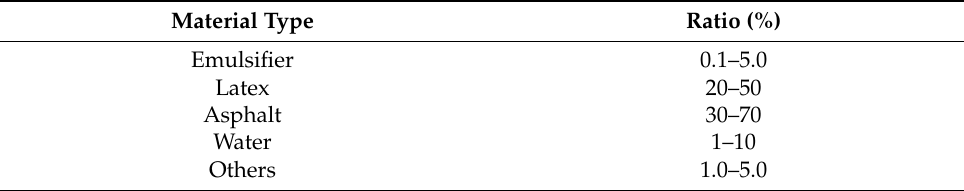
Table 1. Mixing ratio of water-soluble rubber-asphalt-based waterproof coating.